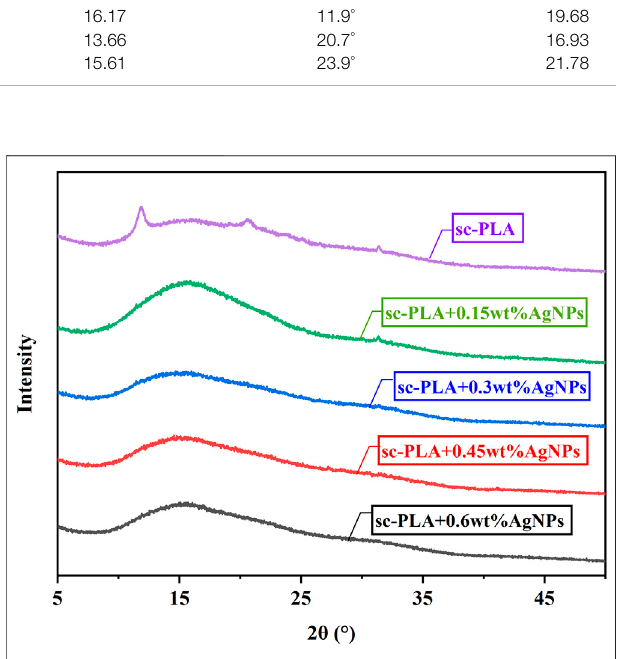
FIGURE 8 | XRD curves of sc-PLA electrospun membranes with different AgNP contents.